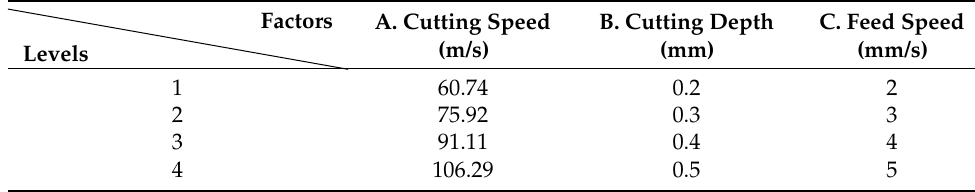
Table 2. Factors and levels in the orthogonal experiment.